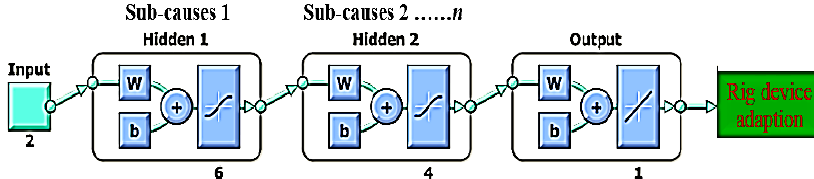
Figure 3. Tackling sub-causes using NN principles.